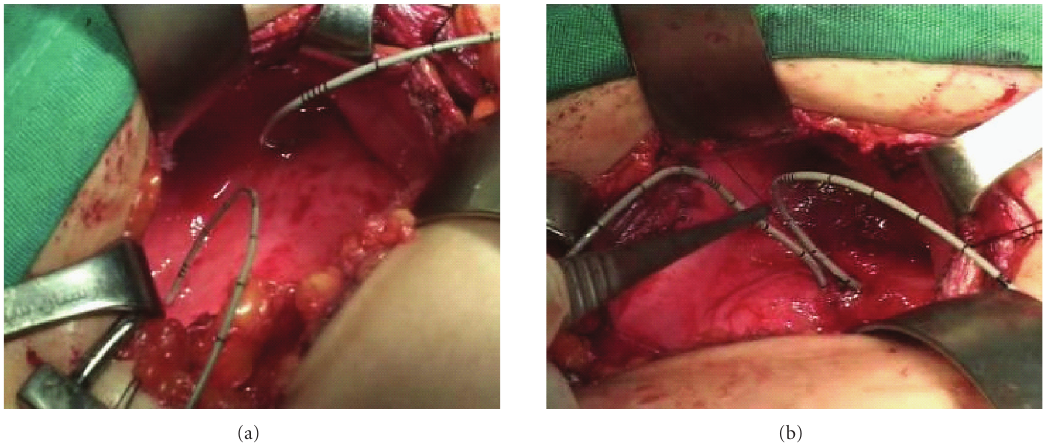
Figure 2: (a) Ureteral orifices of a patient with high-grade bilateral VUR located laterally (wide apart). (b) After performing Gil-Vernet trigonoplasty, ureteral orifices are located in the midline leading to e ff ective detrusor